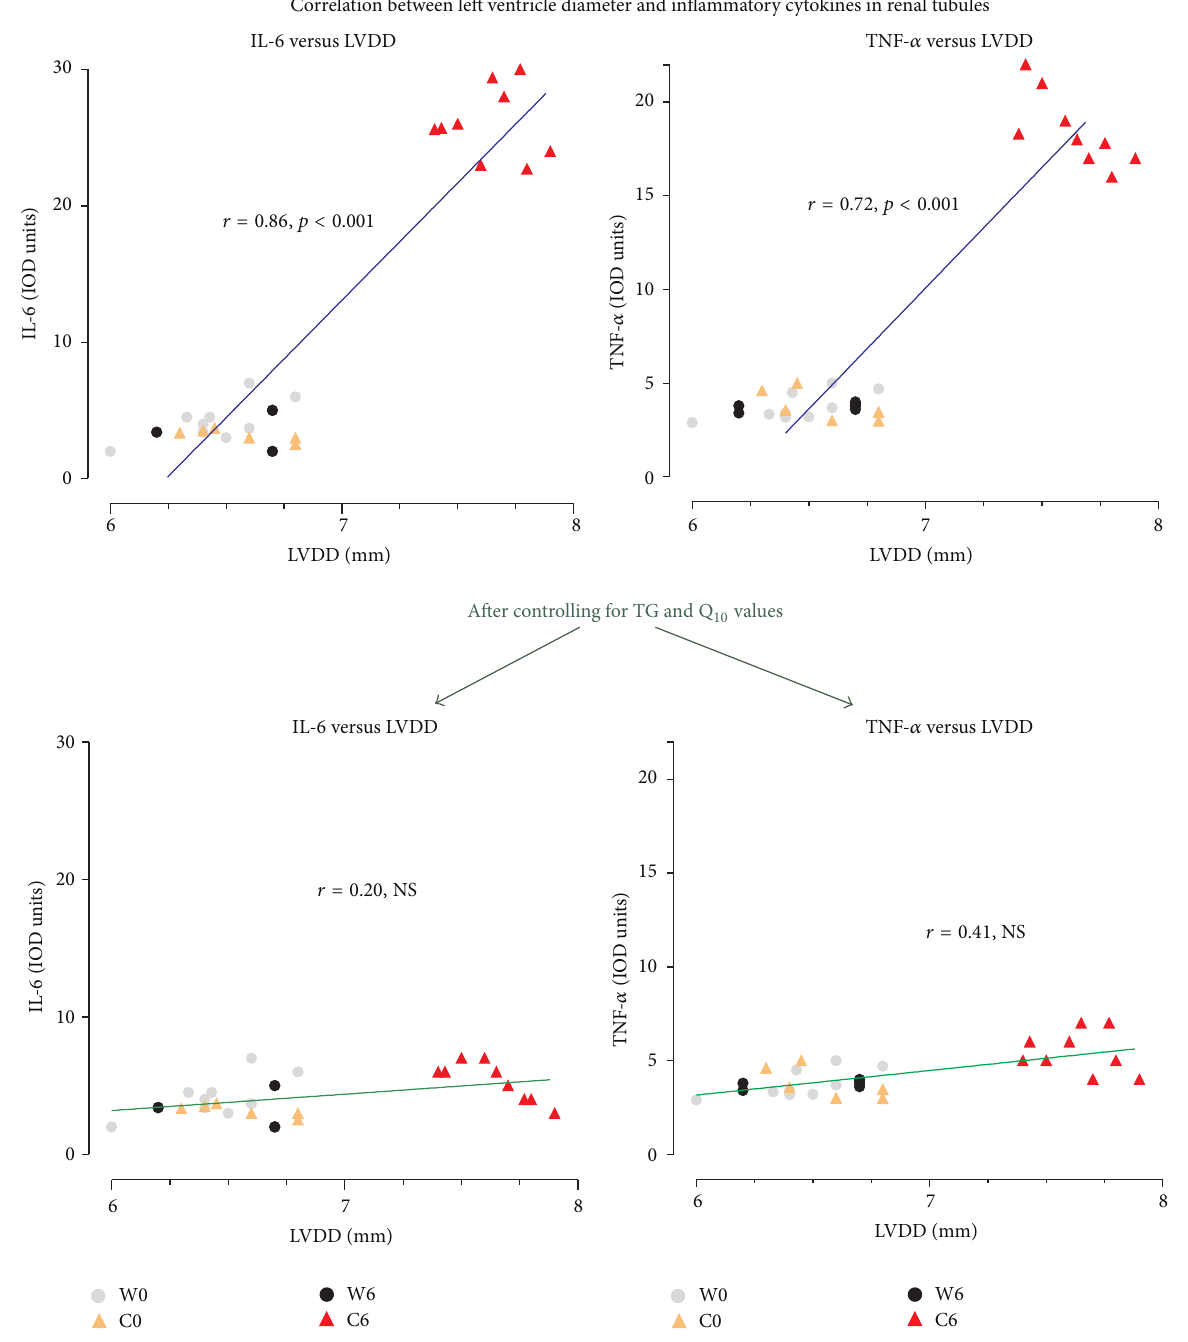
Figure 7: Cardiorenal correlations. Dependence on TG and Q 10 levels. IL-6: interleukin-6, and TNF- 𝛼 : tumor necrosis